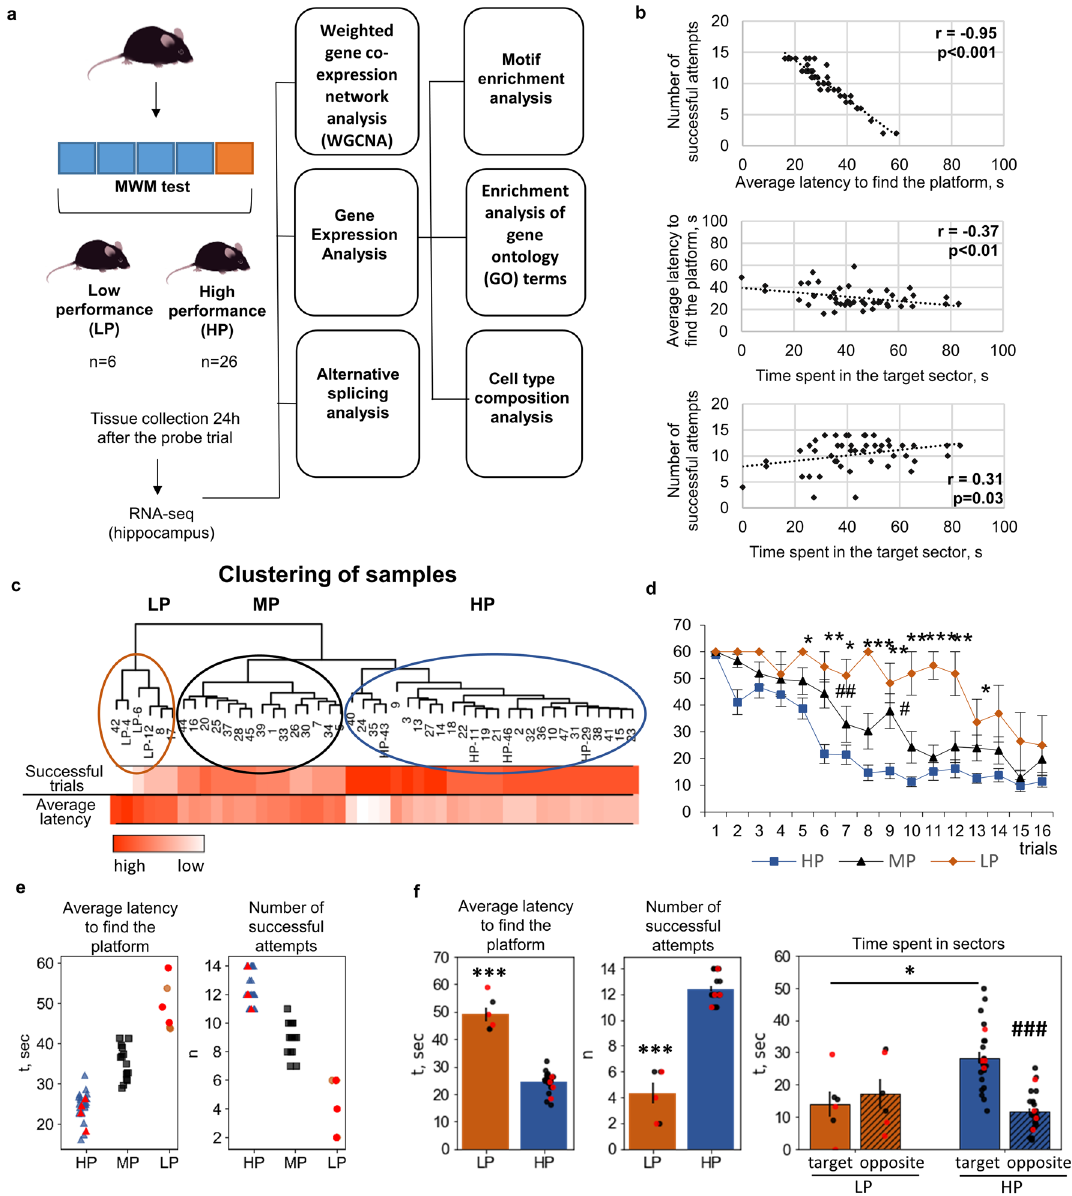
Figure 1. MWM cognitive performance. ( a ) Experimental design. ( b ) The correlation among the parameters of the MWM test among all the mice. ( c ) Hierarchical clustering of samples based on the number of successful attempts to find the platform and the average latency to find the platform in the MWM test. Mice were subdivided into three groups: low (LP), medium (MP), and high (HP) MWM performance. Hippocampus samples from the mice labeled as LP or HP were used in the subsequent transcriptome analysis. ( d ) The learning curve in the MWM test shows the change in latency to find the platform during 16 training trials (four trials a day for 4 days) in groups LP, MP, and HP. ( e ) Scatter plots showing the distribution of numbers of successful attempts to find the hidden platform and the distribution of latency times to find the platform among the animals. ( f ) A comparison of parameters of the MWM test between groups LP and HP. Data are presented as mean ± SEM ( d , f ), * p < 0.05, ** p < 0.01, *** p < 0.001 as compared with the LP group, ### p < 0.001 as compared with the Target